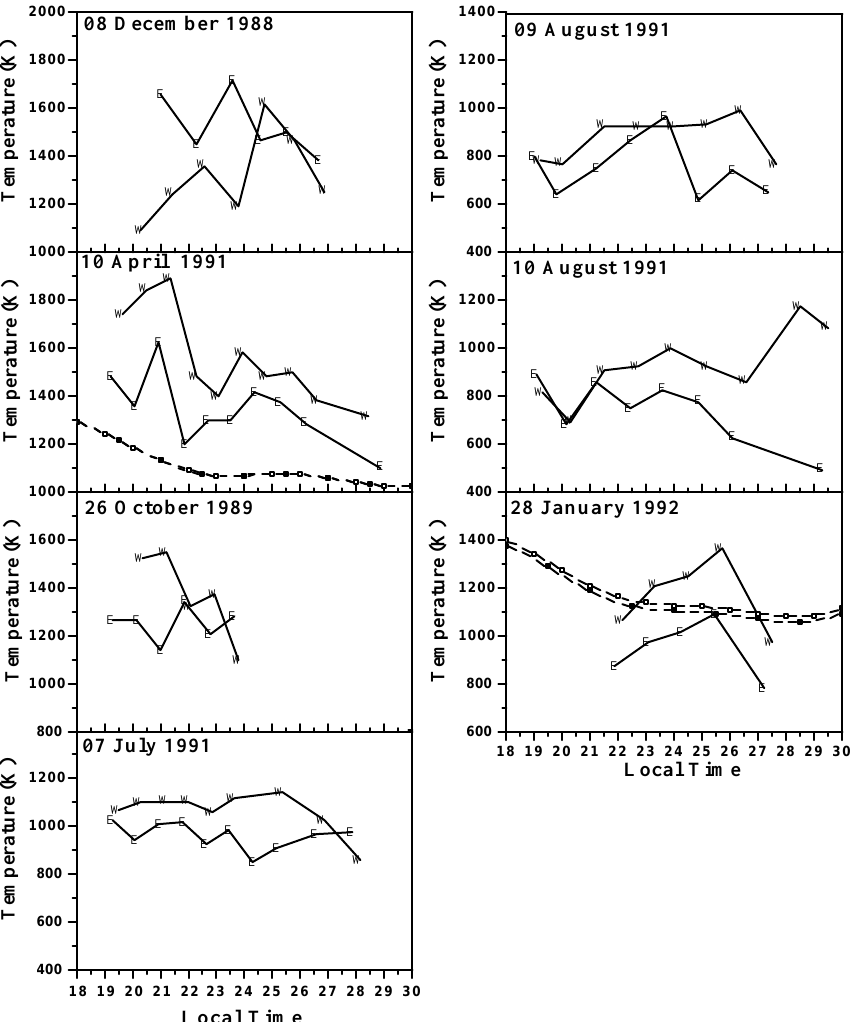
Fig. 3. Nighttime variations of the observed temperatures to the east and west, for representative nights with thermospheric zonal temperature gradi- ents. The temperatures obtained from the MSIS-90 model are also shown for two different longitudes (230 ◦ S, 41 ◦ W, closed square) and (23 ◦ S, 49 ◦ W, open circle) at 270km of alti-